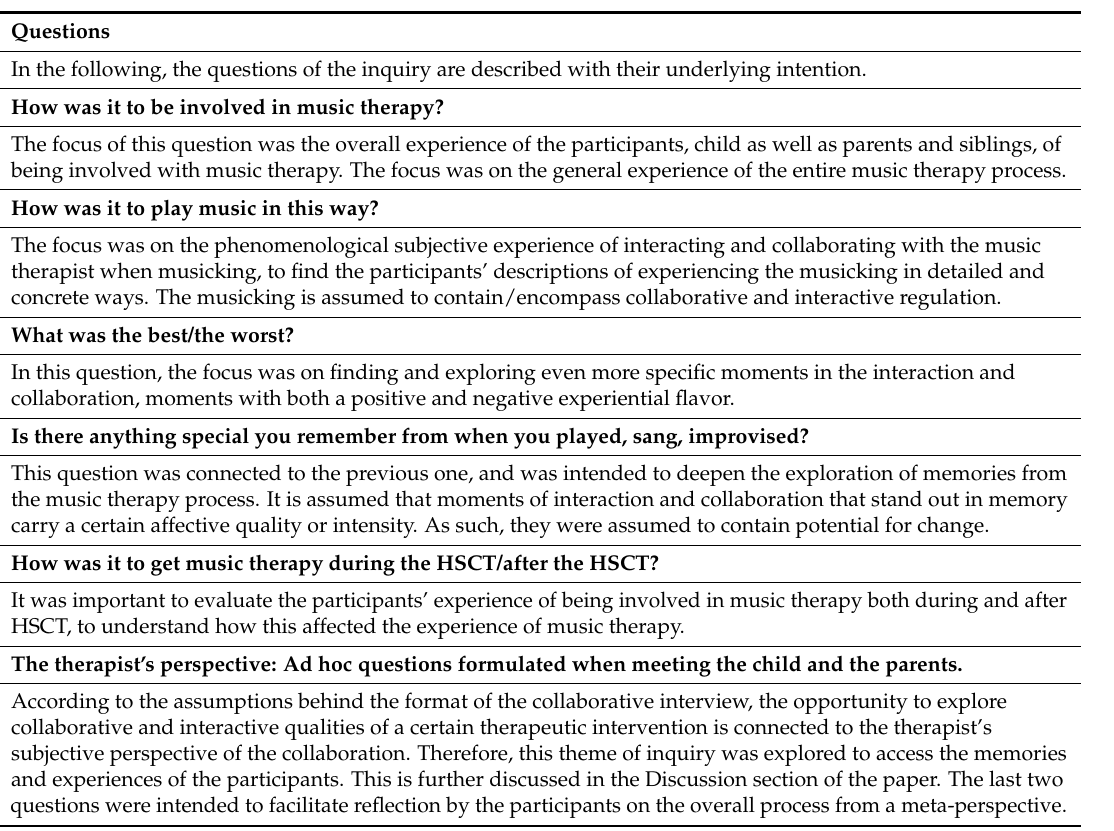
Table A1. Questions of the